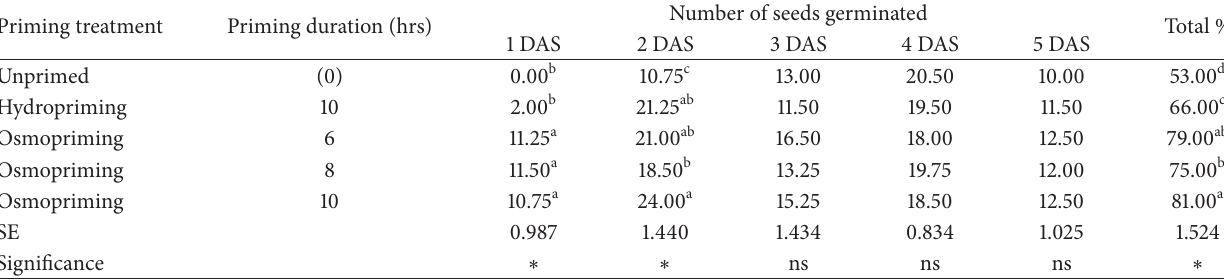
Table 1: Effect of osmopriming duration on germination of cowpea seeds.